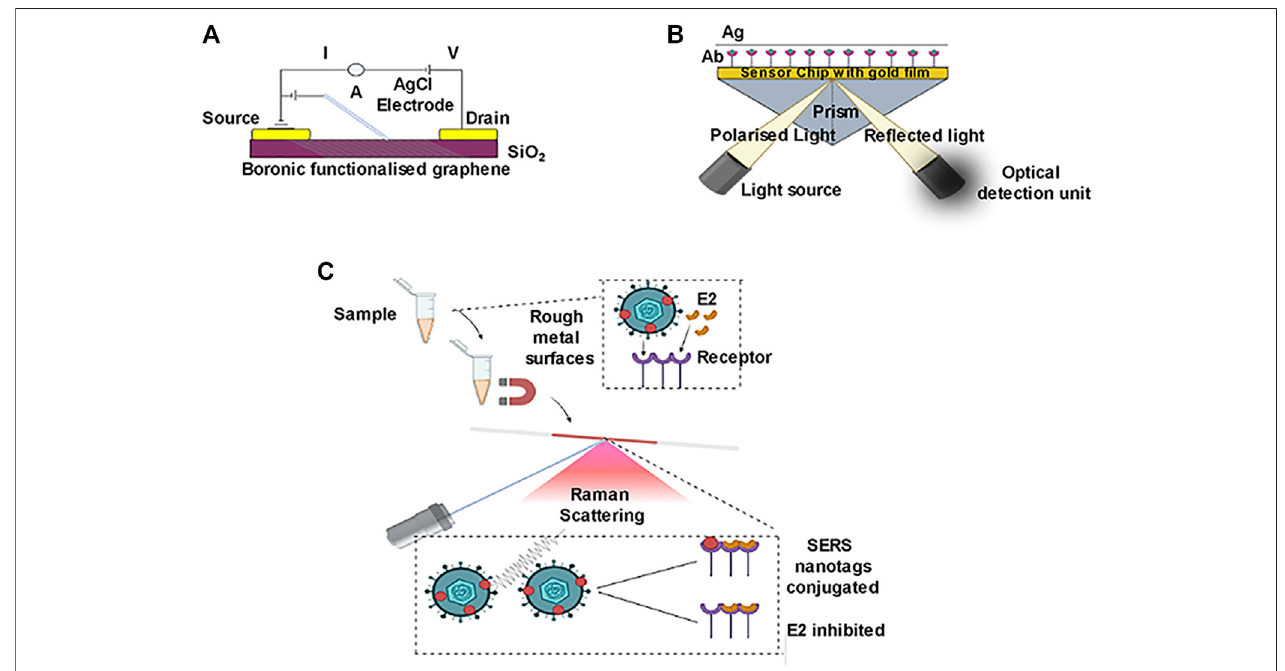
FIGURE 1 | Graphene af fi nity based biosensor. Surface plasmon resonance (SPR) based biosensor. Surface enhanced raman scattering.